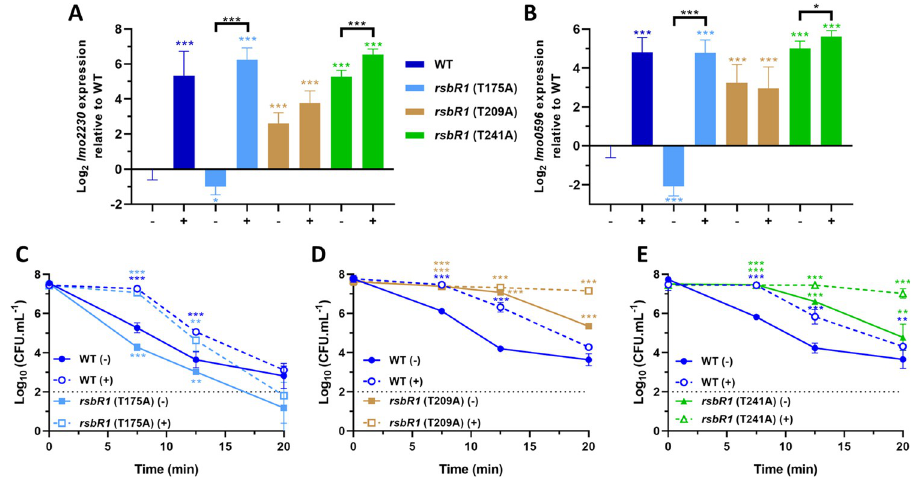
Fig 4. RsbR1 residues T209 and T241 are required for normal acid-mediated activation of σ B and development of acid tolerance. Expression of σ B -dependent genes (A) lmo2230 and (B) lmo0596 , obtained from mid-log phase cultures of wild type and rsbR1 (T175A), rsbR1 (T209A) and rsbR1 (T241A) strains untreated (-) and treated (+) for 15 min in pH 5.0 at 37˚C. Gene expression is expressed as Log 2 relative gene expression. Acid challenge of mid-log phase of (C) rsbR1 (T175A), (D) rsbR1 (T209A) and (E) rsbR1 (T241A) cultures treated in pH 5.0 for 15 min at 37˚C, as previously described in Fig 2D. Survival data is expressed as Log 10 (CFU.mL -1 ). Statistical analysis was performed using a paired Student’s t -test relative to the wild type untreated after 15 min, for RT-qPCR data, and untreated wild type at time 0 min, for acid challenge data ( � , P value of < 0.05; �� , P value of < 0.01; ��� , P value of <